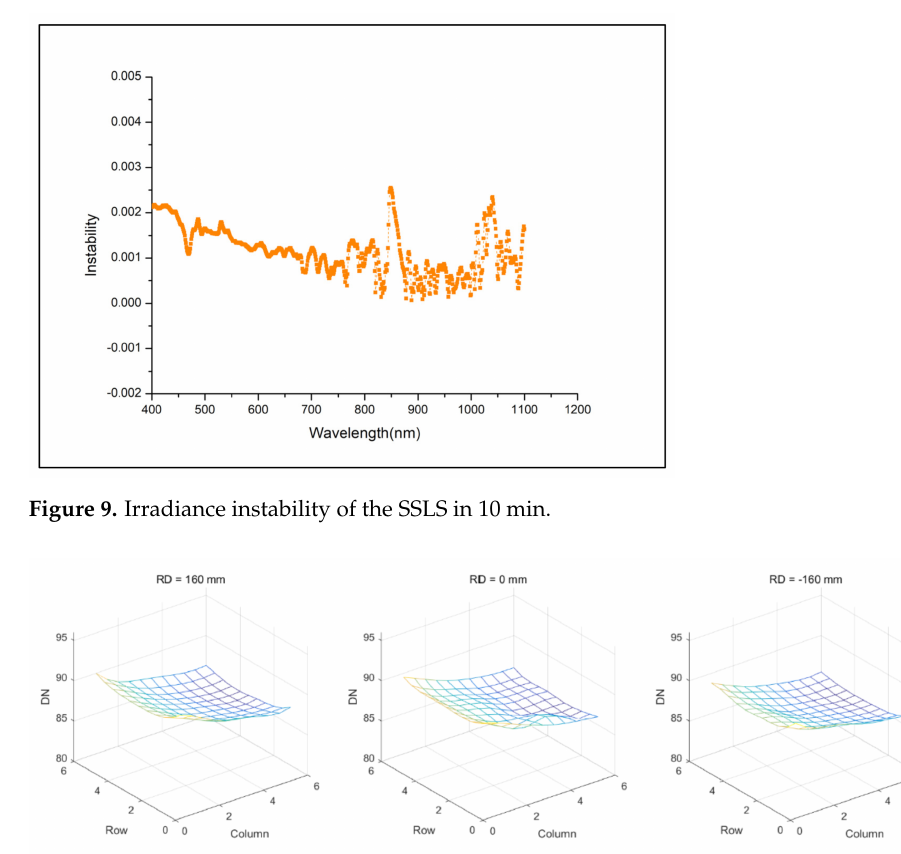
Figure 10. Volume nonuniformity of the